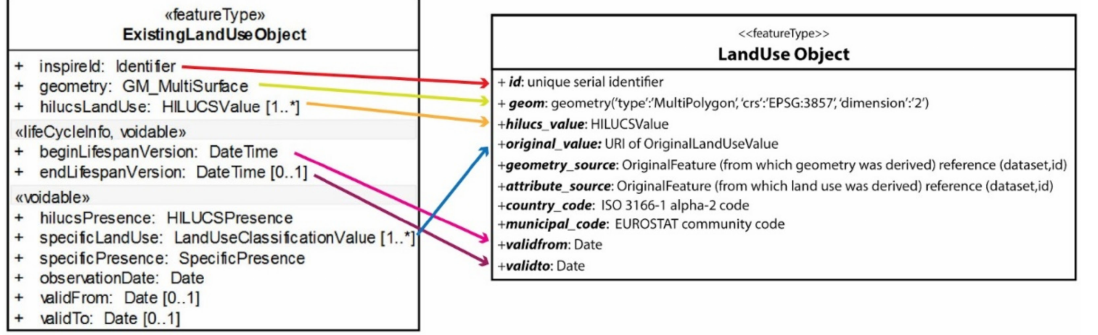
Figure 1. Initial OLU data model and mapping attributes between the OLU model and INSPIRE ExistingLandUseObject